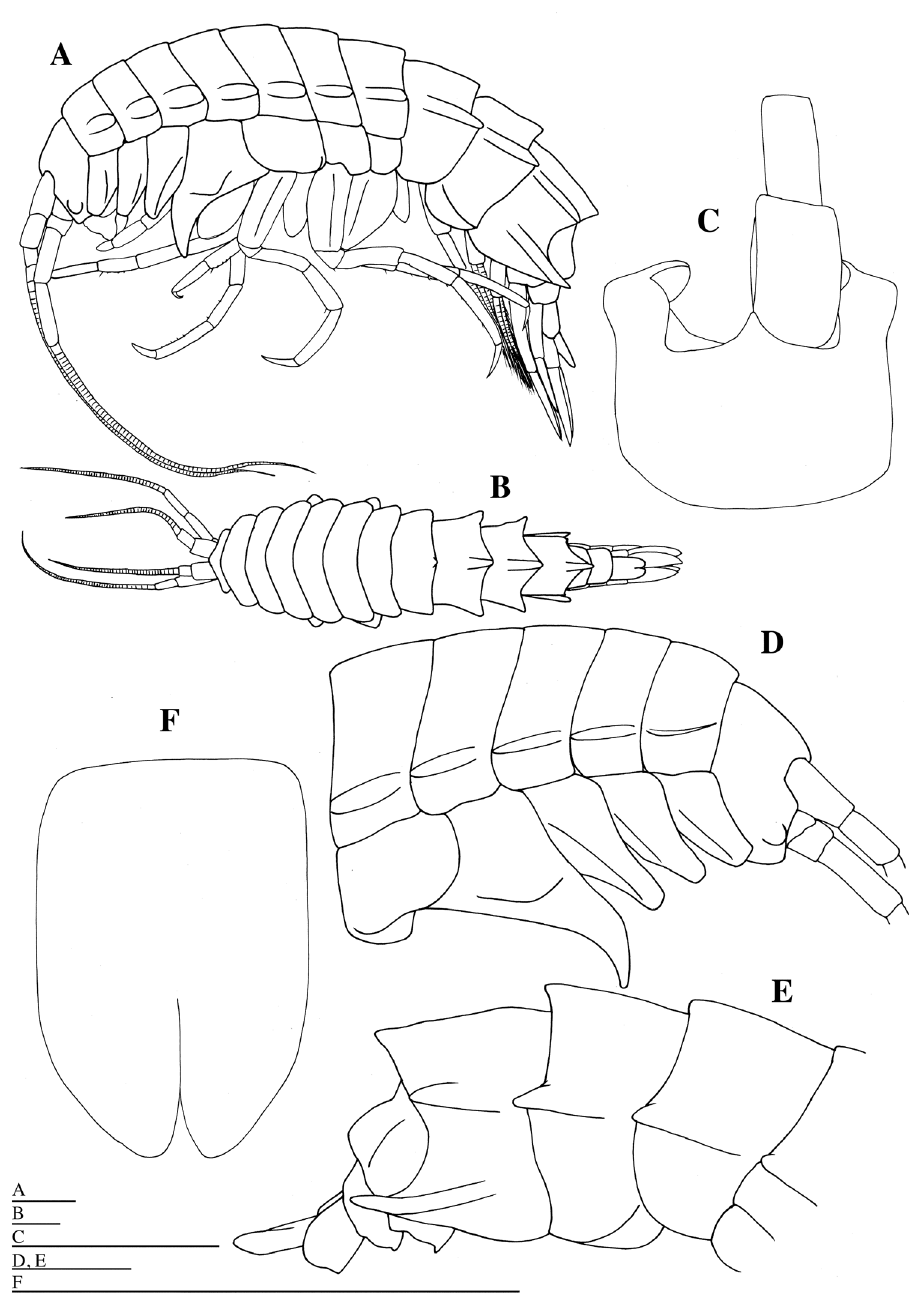
Figure 1. Epimeria abyssalis sp. n., holotype female: A habitus, lateral B habitus, dorsal C head and articles 1 and 2 of right antenna 1, dorsal D anterior part of body, lateral E posterior part of body, lateral F telson, dorsal. Scale bars: 5